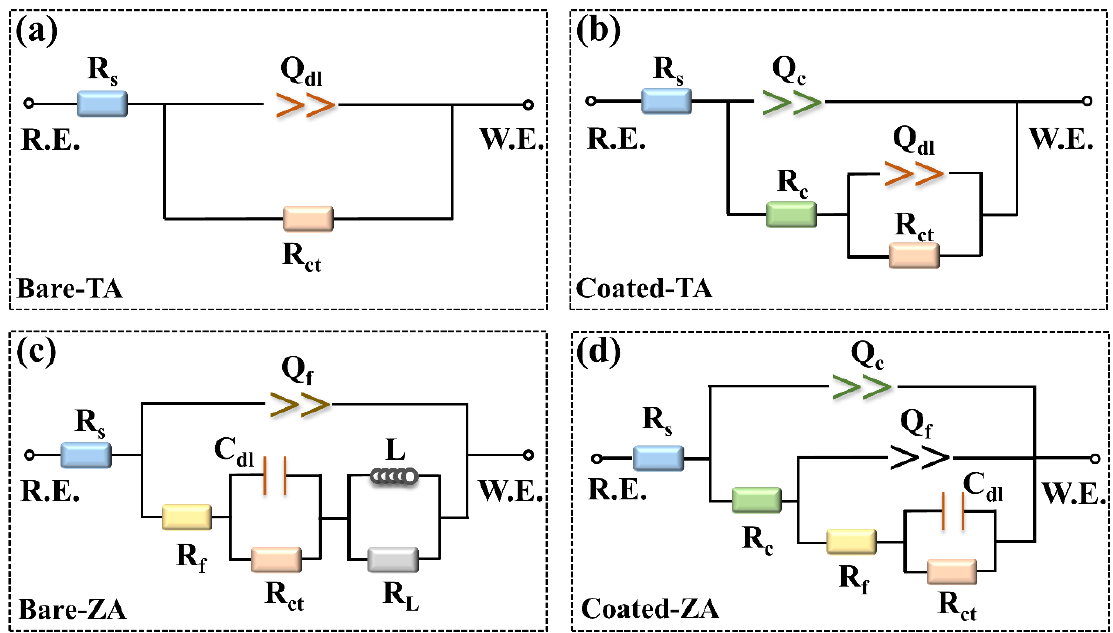
Figure 6. The equivalent electrical circuits are used to fit the impedance behaviors of ( a ) Bare ‐ TA, ( b ) Coated ‐ TA, ( c ) Bare ‐ ZA, and ( d ) Coated ‐ ZA. R.E.: reference electrode, W.E.: working electrode.